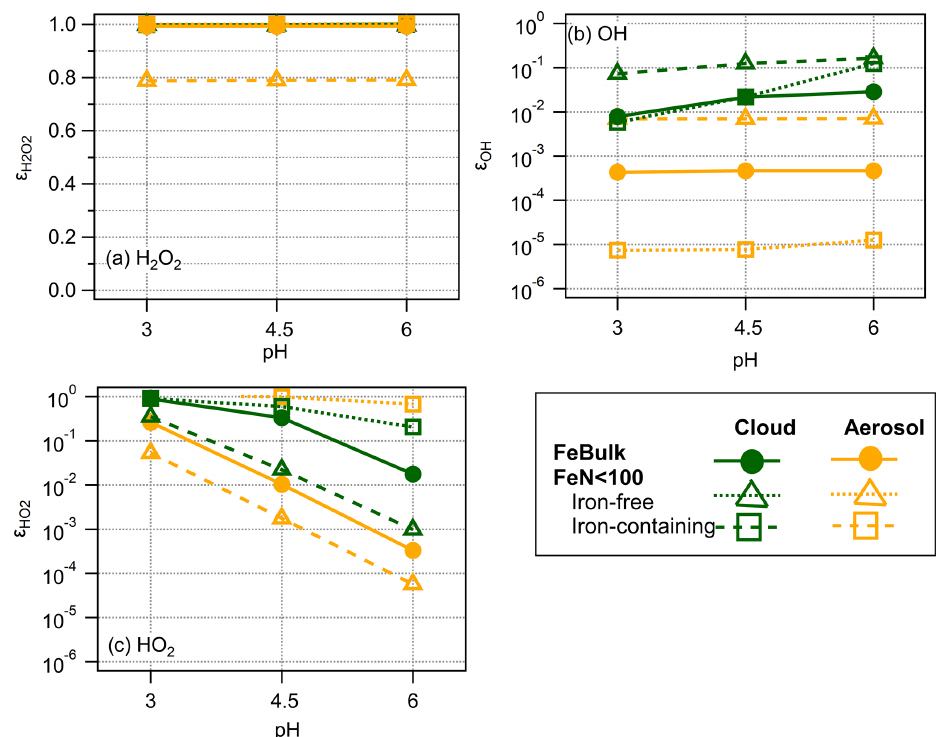
Figure 4. Partitioning coefficients (cid:15) for (a) H 2 O 2 , (b) OH and (c) HO 2 for pH = 3 , 4.5 and 6 for FeBulk (filled symbols) and FeN < 100 in 98% iron-free (squares) and 2% iron-containing droplets (triangles). Results are shown for simulations of cloud droplets (green) and aerosol particles (orange) at three pH values (3, 4.5 and 6); lines are added to guide the eye.